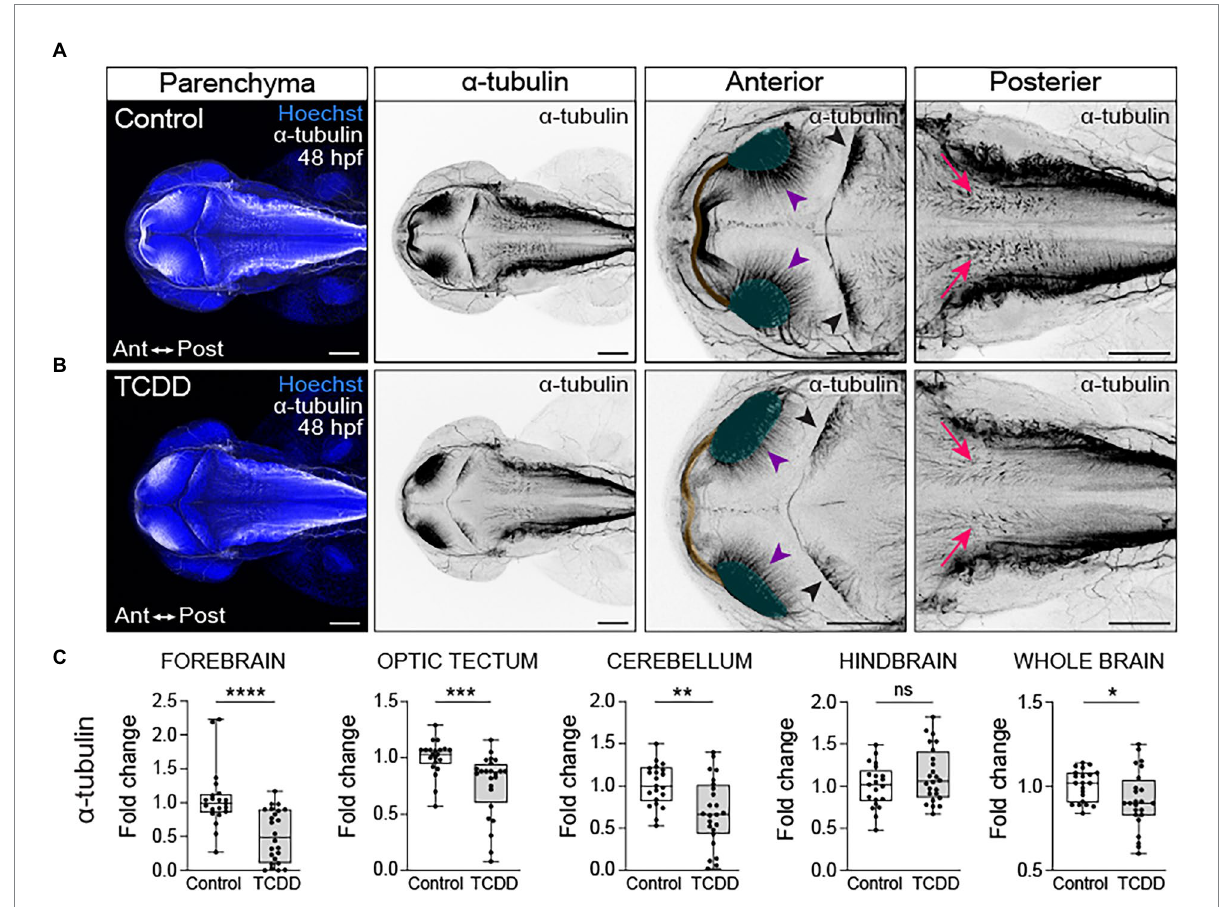
FIGURE 3 Embryonic TCDD exposure disrupts neural network formation. Dorsal confocal images of axon tracts in control (A) and TCDD-exposed (B) embryos at 48 hpf. The brain parenchyma is marked by Hoechst staining (DNA, blue) and axon tracts are immunolabeled with an anti- acetylated α tubulin ( α -tubulin) antibody (white and inverted black signal). Projections emanating from the optic neuropils (green shading and purple arrowheads) were reduced in TCDD-exposed embryos. The posterior commissure (yellow shading) appears defasciculated following TCDD exposure. Purkinje cells in the cerebellum (black arrowheads) were malformed in TCDD-exposed zebrafish relative to controls. Although the area covered by acetylated α -tubulin in the hindbrain was not statistically different between groups, we noted that the acetylated α -tubulin projections in the hindbrain (pink arrows) appear diminished in TCDD-exposed embryos. (C) Fold change of acetylated α -tubulin in the forebrain, optic tectum, cerebellum, hindbrain, and whole brain calculated relative to average α -tubulin area coverage in controls. Statistical significance determined by Welch’s t -test, * p < 0.05, ** p < 0.01, *** p < 0.001, **** p < 0.0001. n = 21–26 fish/group across 3 replicates. Anterior (Ant) is left in all confocal micrographs. First 2 panels containing confocal micrographs in A and B are at a 10x magnification. All other confocal micrographs are at a 10x magnification with a 2.5 digital zoom). Scale bar = 100 μ